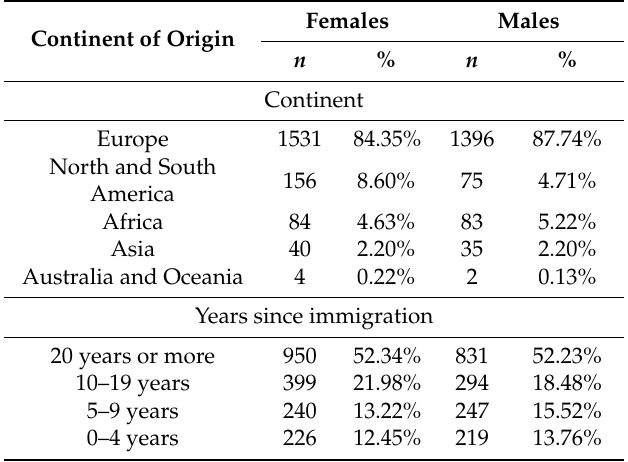
Table 2. Continents of origin and years since